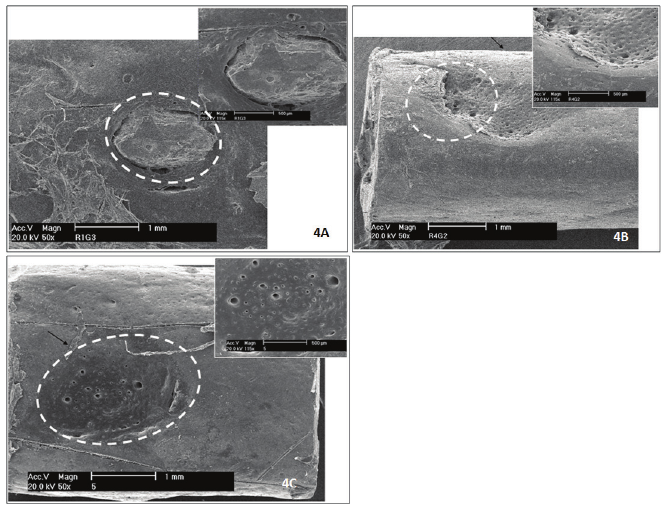
FIGURE 4 - Scanning electron microscopy findings (Group IV). A ) Arrows indicate the interface between bone tissue and the α-TCP+AB implant, at 30 days. B ) Arrow indicates direct contact between bone tissue and implant material, at 60 days. C ) Arrow indicates areas suggestive of neovascularization within the implant material, at 120